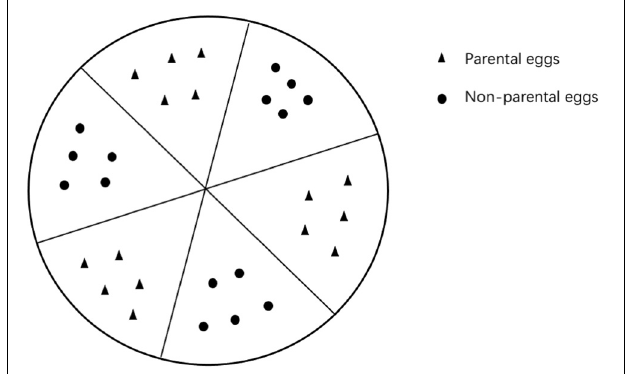
FIGURE 1 | Set-up and distribution of the two kinds of eggs in the free-choice